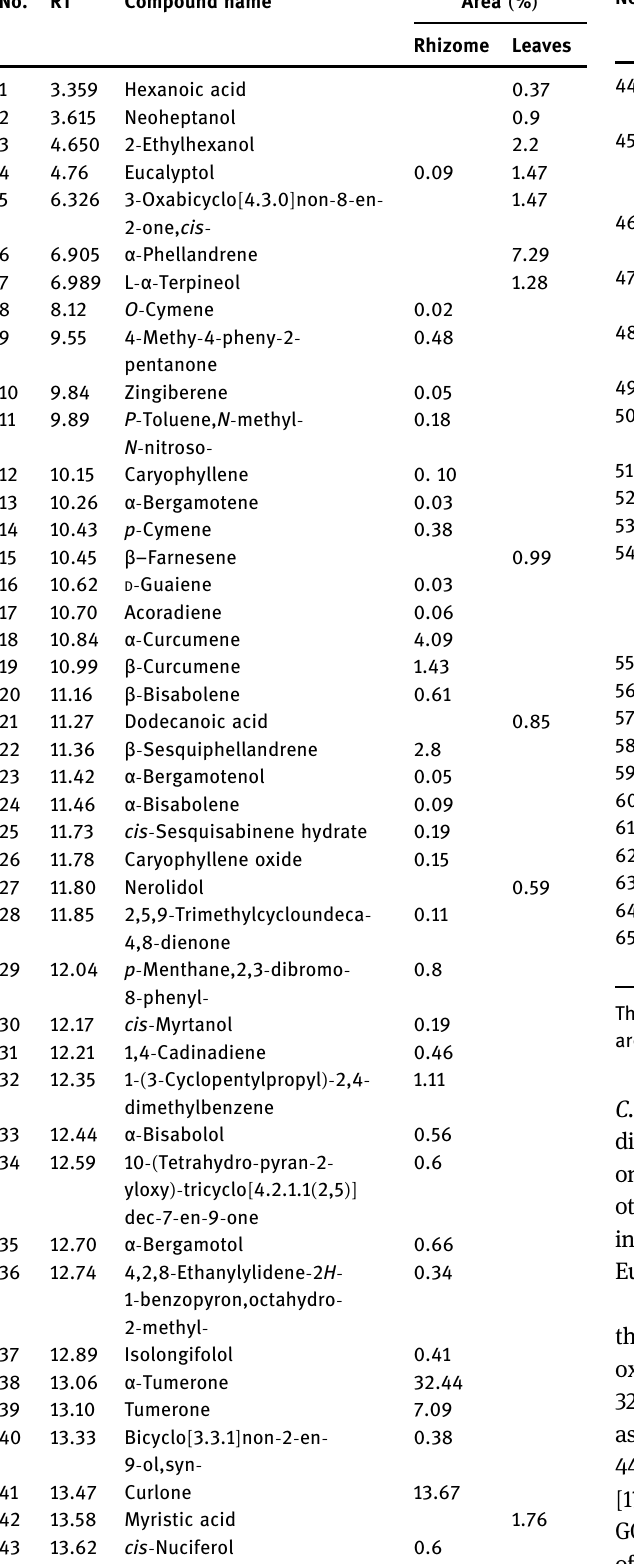
Table 3: GC/MS pro fi le of Curcuma longa rhizome and leaves oils No.